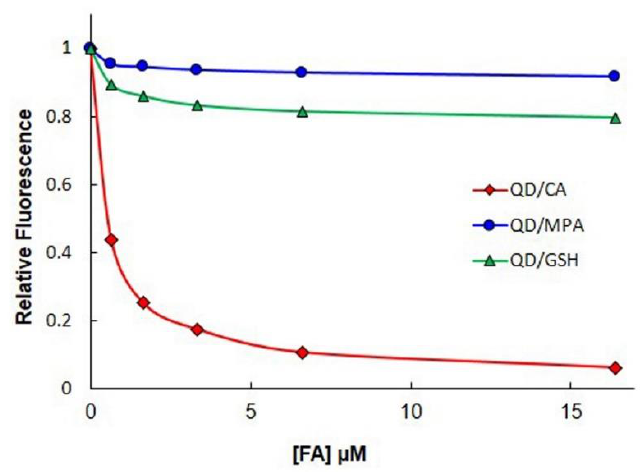
Figure 4. Response profile of CdTe QDs with different coating ligands (CA, mercaptopropionic acid (MPA), glutathione (GSH)) toward FA.